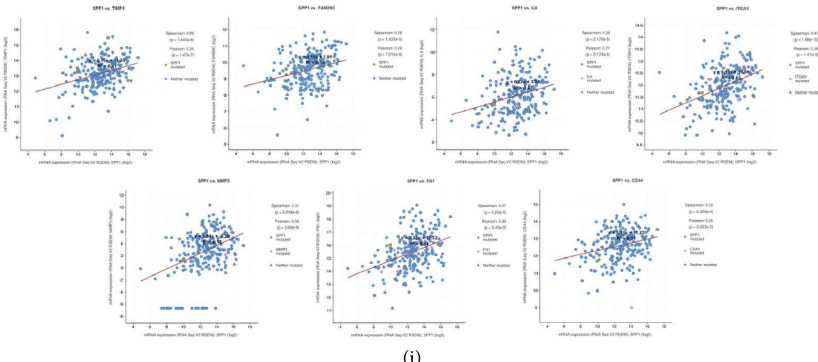
Figure 10: TebiologicalroleofSPP1intumors.(a)Immunohistochemicalanalysisof normallung tissuesandlungadenocarcinomawiththeHPA online tool, andSPP1 wasfound to be highly expressed in LUADtissues. (b) Expression of SPP1in varioustumors. (c) Te methylation level of SPP1 in normal lung tissues and lung adenocarcinoma. (d) Expression of SPP1 in lung adenocarcinoma based on nodal metastasis status. (e) Interacting proteins for SPP1 gene STRING interaction network preview (showing top 10 STRING interactants). (f) Beautify the results of KEGG pathway analysis with the CLUGO plugin in Cytoscape software. (g) Variation of SPP1 related genes in the lungs. (h) Analysis of the network of regulatory pathways of the 11 genes. Te white is for tumor-targeted drugs, and yellow is for oncology drugs approved by the FDA. (i) Te scatter plot showed the correlation between the SPP1 expression and the 7 hub gene signature. ∗ P < 0 . 05, ∗∗ P < 0 . 01, and ∗∗∗ P < 0 .